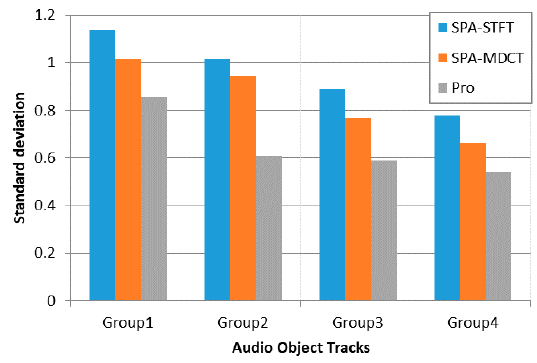
Figure 4. The standard deviation of ODG score of four multi-track audio files.